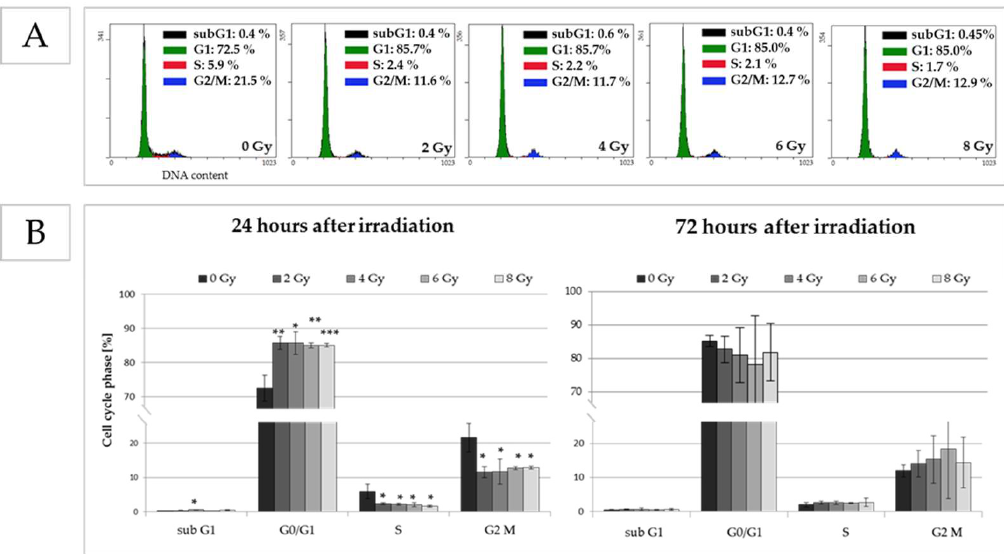
Figure 4. Effect of irradiation on cell cycle progression after an incubation time of 24 and 72 h. Distribution of cells in cell cycle phases (G0/G1, S and G2/M) and cells with degraded cell DNA (subG1) was determined by flow cytometry using propidium iodide (PI) to measure the DNA content of each cell. ( A ) Exemplary histograms of cell cycle assay by flow cytometry of unirradiated (0 Gy) and irradiated pADSCs (0.25, 1, 2, 4, and 6 Gy), 24 h after the irradiation procedure; on the right corner of each image, results are illustrated as mean ± standard deviation (SD, n = 3); ( B ) Graphical illustration of cell cycle distribution of unirradiated and irradiated cells; asterisks illustrate significant differences to unirradiated cells (control): * p < 0.05; ** p < 0.01; *** p < 0.001 (students t -test and two-way ANOVA with Bonferroni post-hoc test).